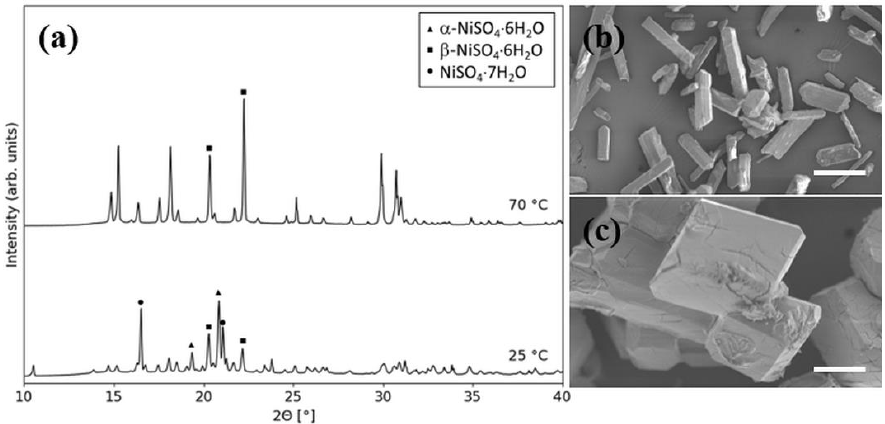
Figure 5. ( a ) XRD spectra of nickel sulfate crystals produced with 0.2 g α -NiSO 4 .6H 2 O seeding and without impurities at 25 °C and 70 °C, showing the effect of crystallization temperature. ( b , c ) SEM images of crystals precipitated at 25 °C and 70 °C, respectively. Scale bar: 100 µm.